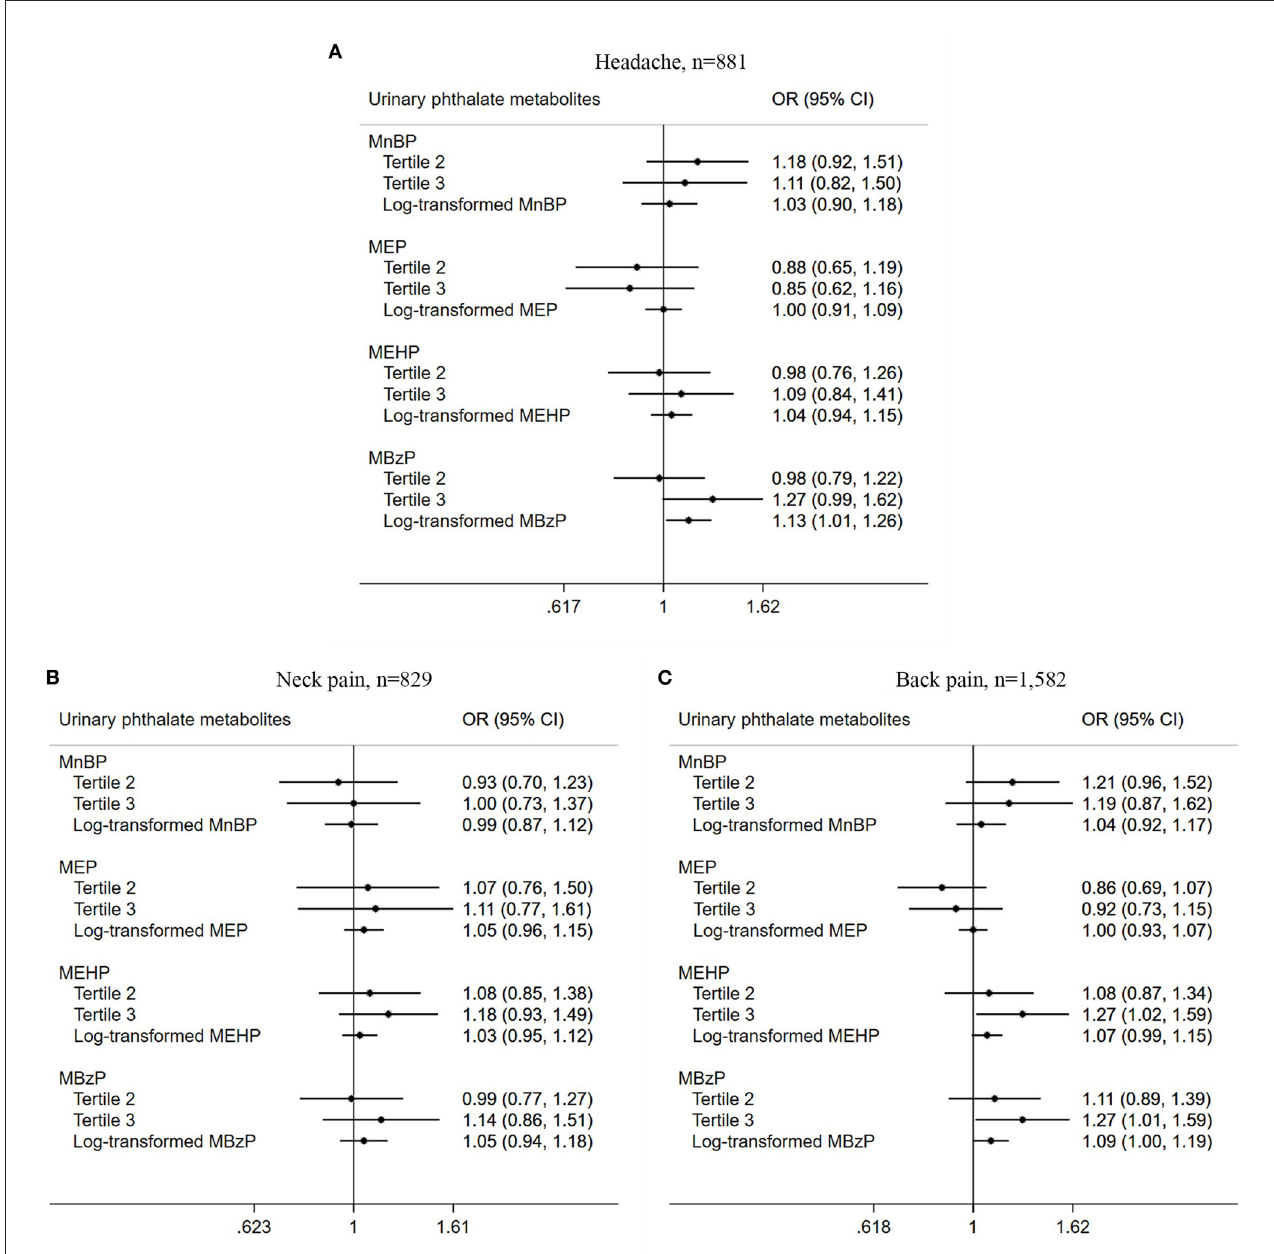
FIGURE3 Association between urinary phthalate metabolites and chronic pain among US adults stratified by site. (A) Headache, n = 881; (B) Neck pain, n = 829; (C) Back pain, n = 1,582.